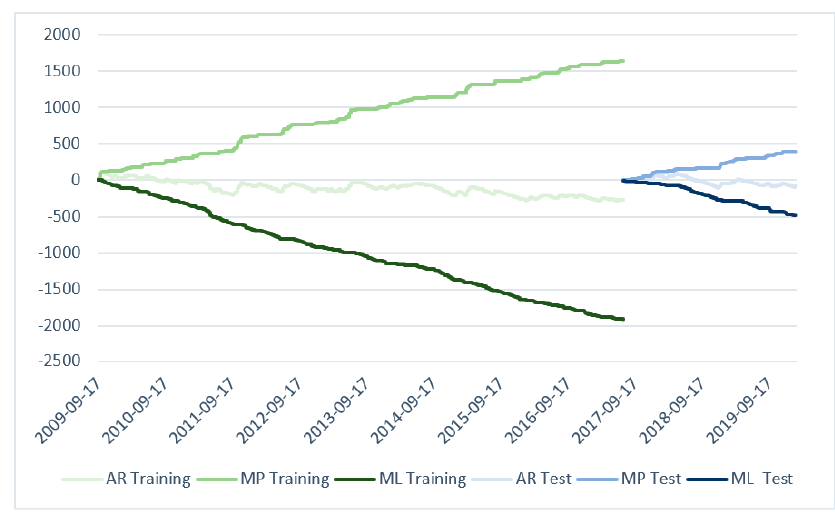
Figure 4. Development of the indicators (MP, ML, AR) over time for the training set and the test set.